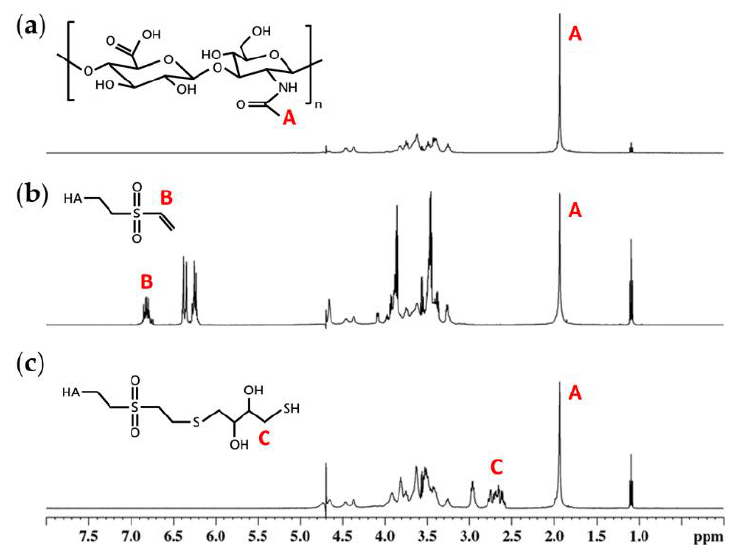
Figure 2. H 1 -NRM spectra of ( a ) hyaluronan (HA), ( b ) divinyl sulfone functionalized HA (HA-VS) polymer, and ( c ) thiolated HA (HA-SH) polymer. The degree of modification of HA-VS polymer was 29% calculated by comparing the area under peak at 6.8 ppm (carbon − carbon double bond of vinyl sulfone groups), indicated by B, to peak at 1.9 ppm ( N -acetyl glucosamine of HA), indicated by A.